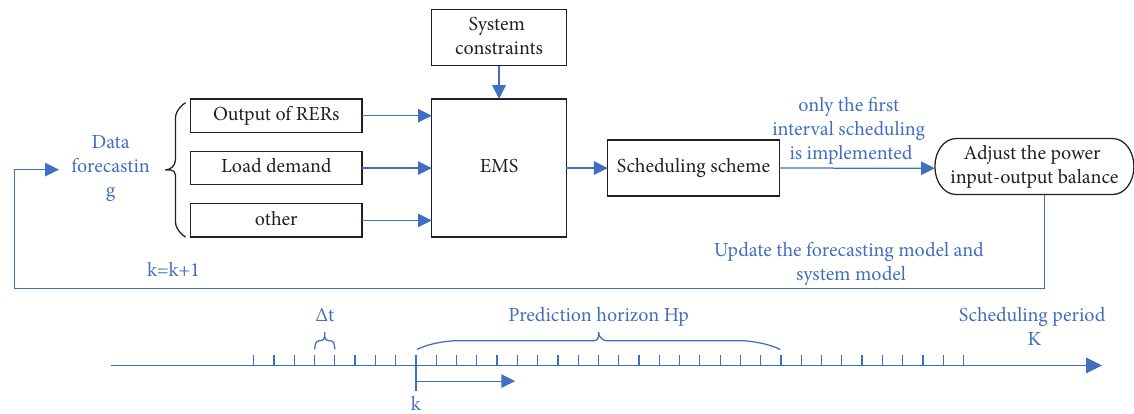
Figure 1: The traditional schematic overview of the traditional